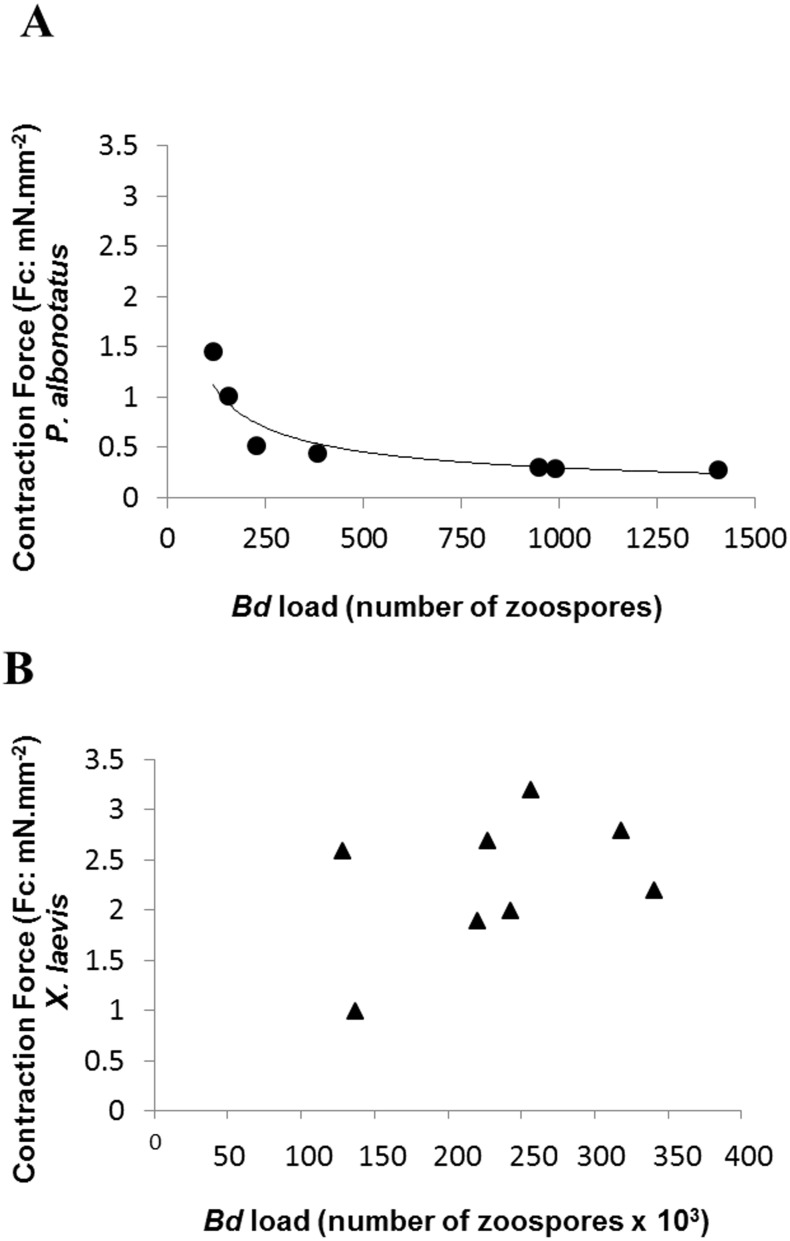
Correlation: Bd load vs. Contraction Force.Correlation between the Bd load acquired by each specimen and the contraction force (CF: mN mm−2) developed by the respective ventricular strips (at 0.2 Hz of stimulation frequency) of P. albonotatus (A: Line equation y = 20.986 ×  − 0.617; r2 = 0.8999) and X. laevis (note that there was no correlation for this species).